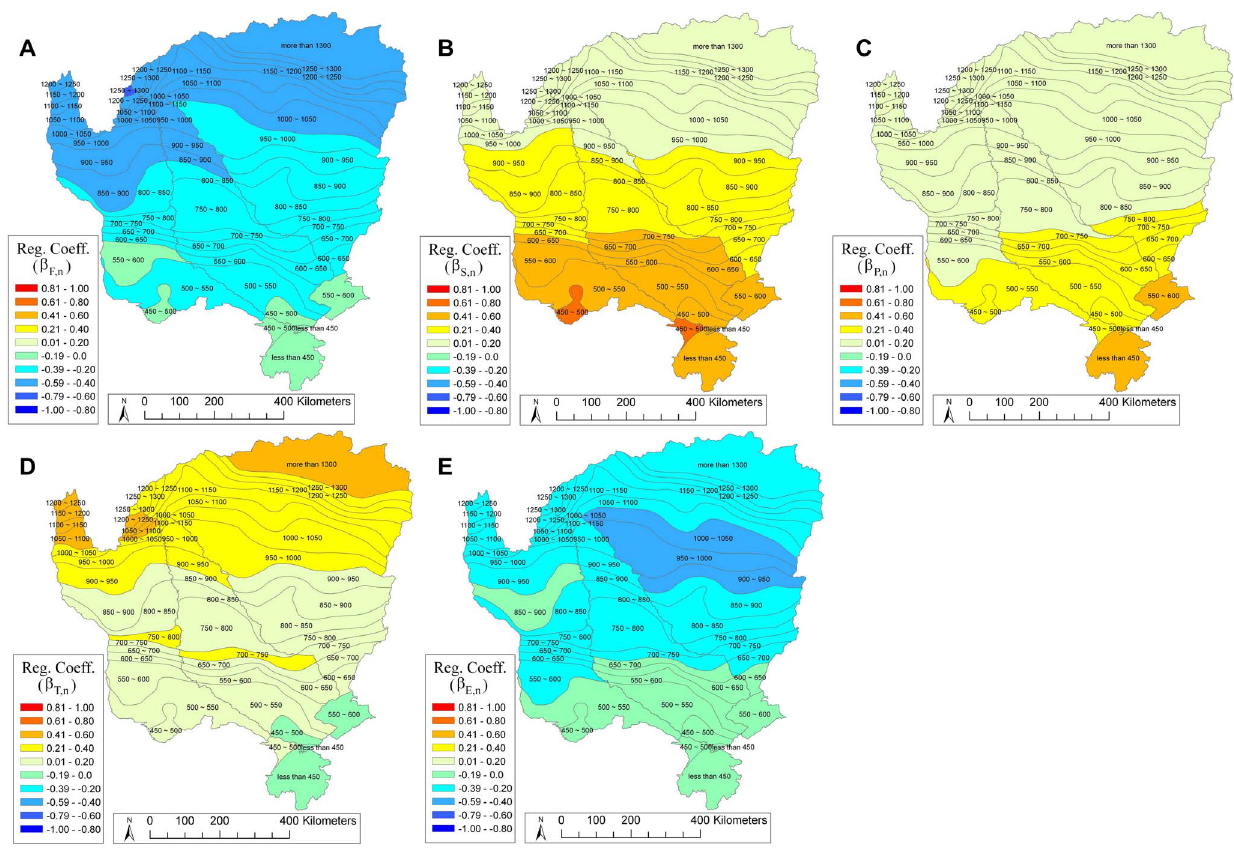
Figure 7. Spatial importance of the five explanatory variables in final NDVI model III. Importance is represented by the distribution of the b k,n regression coefficients (values 2 1 to 1) for each variable: ( A ) fire, F; ( B ) soil moisture, S; ( C ) precipitation, P; ( D ) mean temperature, T; and ( E ) potential evapotranspiration, E.